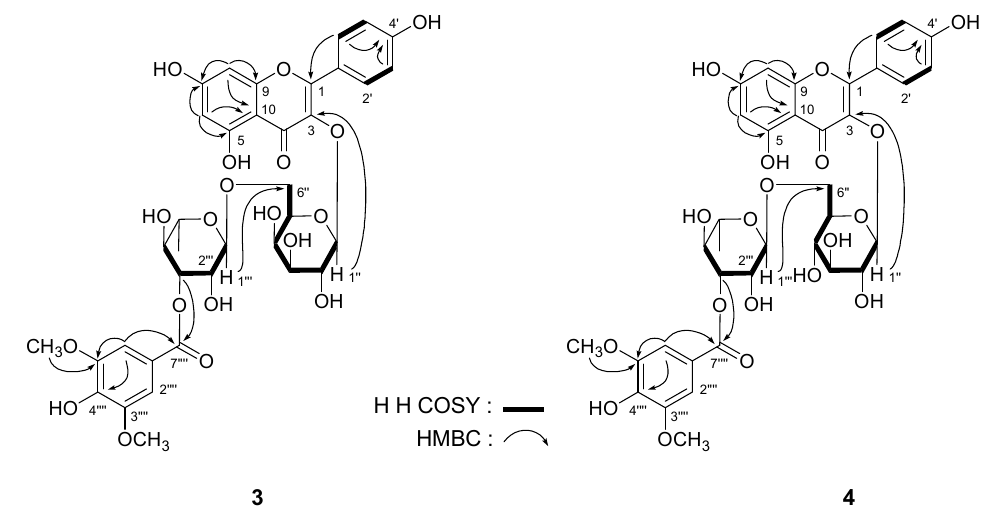
Figure 3. The main 1 H- 1 H COSY and HMBC correlations of compounds 3 and 4